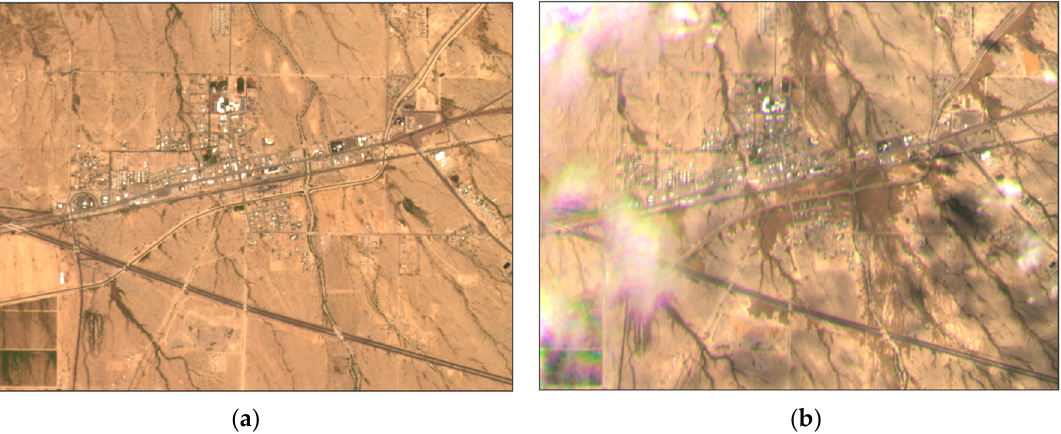
Figure 3. Satellite aerial imagery of Gila Bend from ( a ) 8 May 2021 (dry condition), and ( b ) 15 August 2021 (1 day after the flood event), captured by PS imagery.